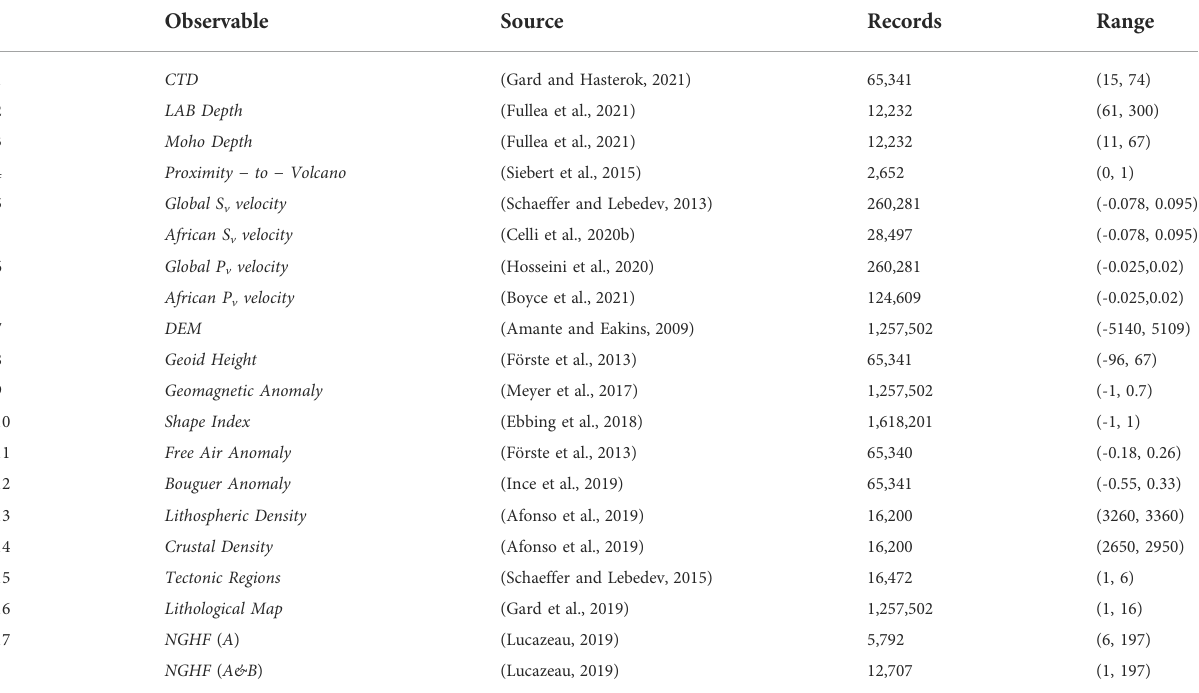
TABLE 1 The observables used in this study with their sources, number of records and